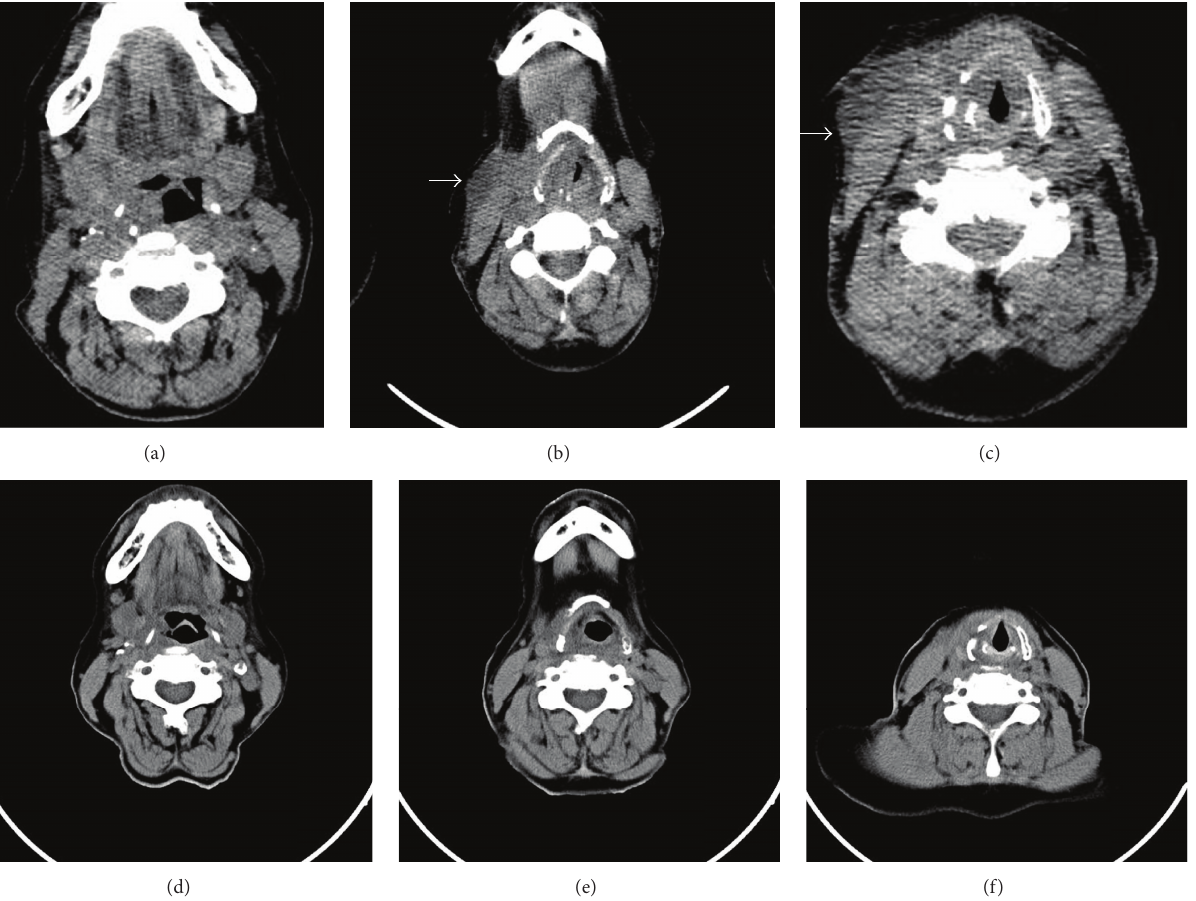
Figure 2: Cervical CT-scan of the laryngeal mass before (upper row: (a), (b), and (c)) and after (lower row: (d), (e), and (f)) radiotherapy.